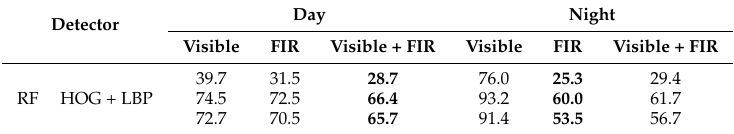
Table 4. AMR (average miss rate) in the KAIST dataset. The three rows in each cell represent the AMR for near, medium and reasonable pedestrians, as explained in the text. Detector Day Night